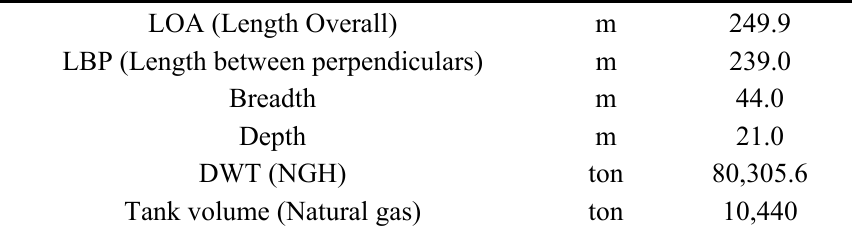
Table 1. Principal particulars of the proposed NGH